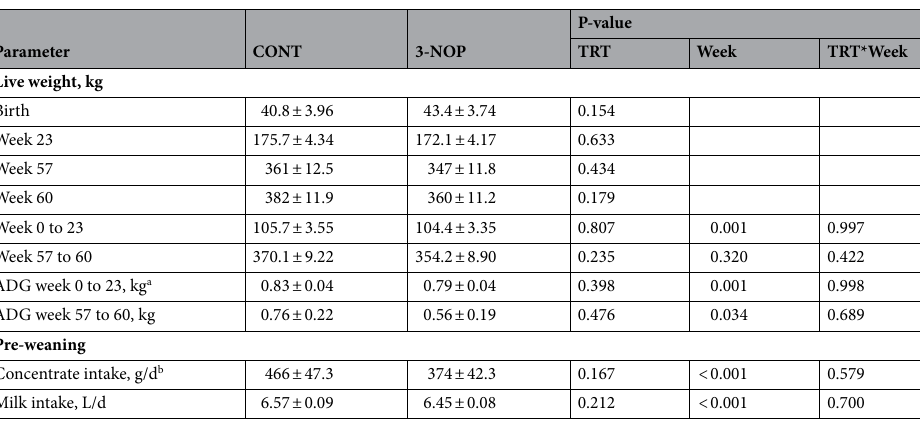
Table 1. Live weight, growth and pre-weaning intake of dairy calves supplemented with 3-NOP (3 mg/kg BW) until 60 weeks of age. Values are presented as means ± SE. n = 8 in CONT; n = 10 in 3-NOP group up to week 23, n = 9 for week 57 to 60. a Average daily gain, ADG. b Intake of hay was not determined on an individual basis as it was offered to the entire group, concentrate intakes may reflect variability in hay intake in young ruminants.